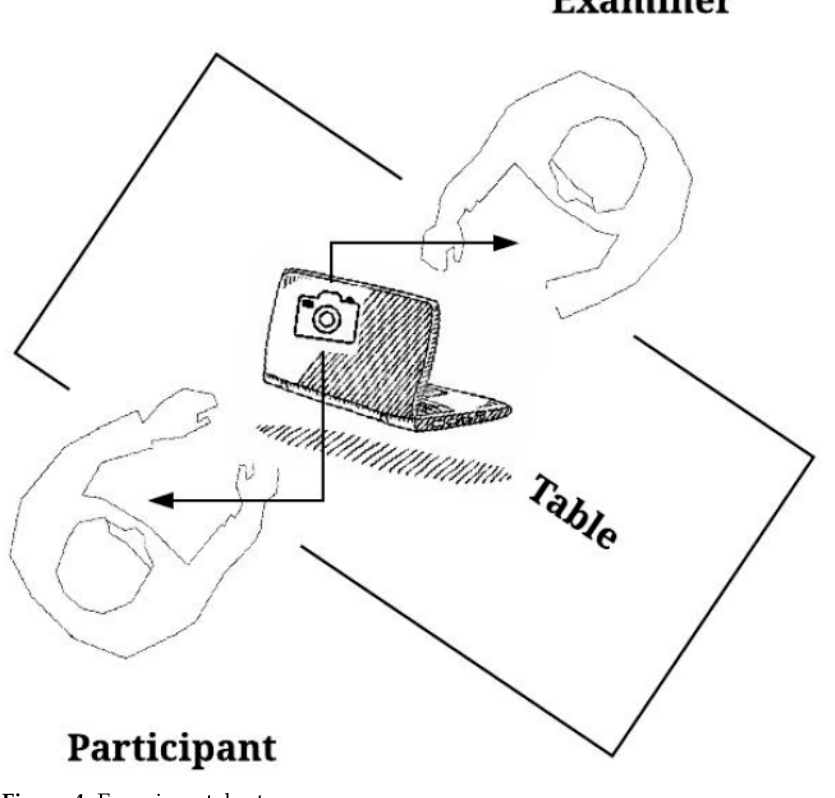
Figure 4. Experimental